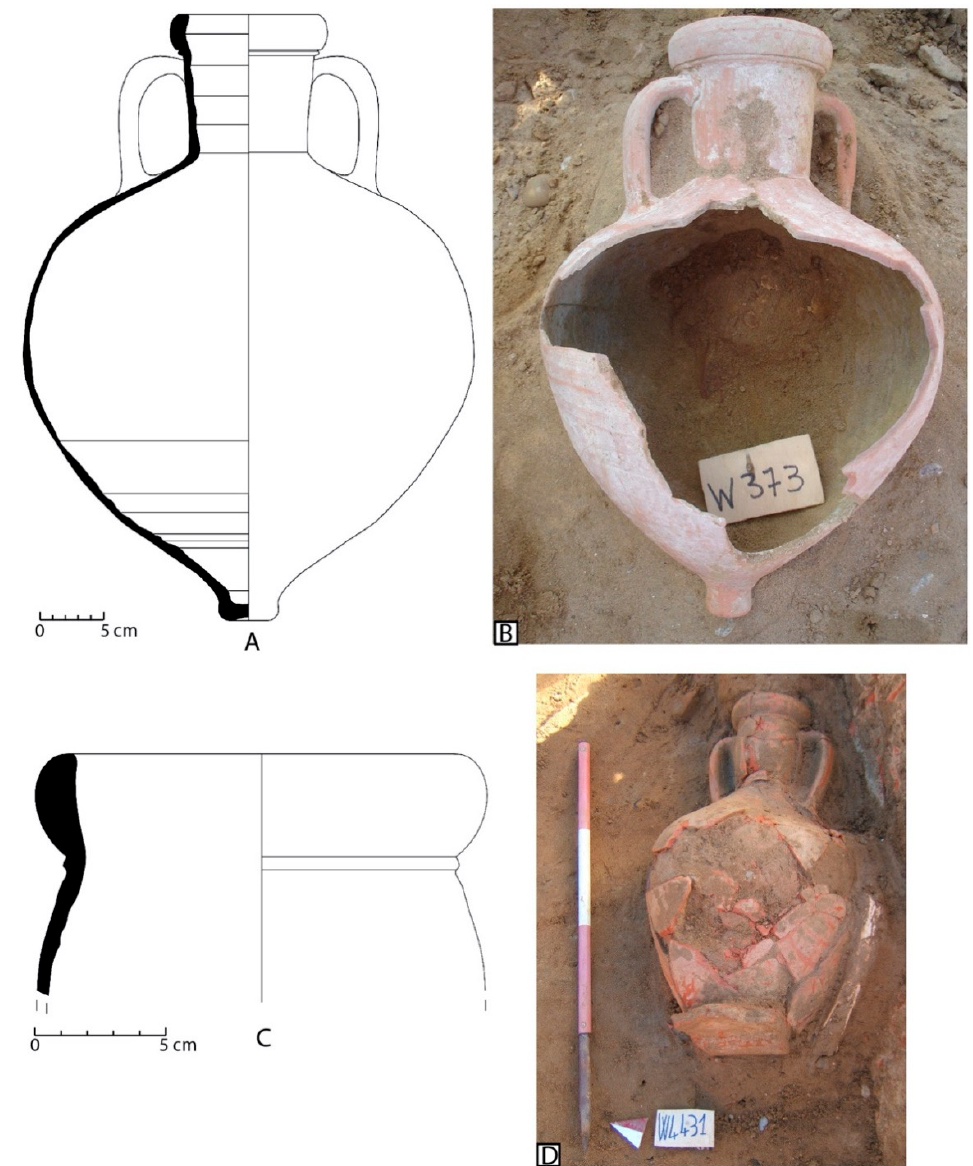
Figure 4. Amphora production of Himera, Randform 3, variant B. ( A , B ) W373 / M 179 / 158; Randform 7 ( C , D ) W4431 / M 179 / 230.